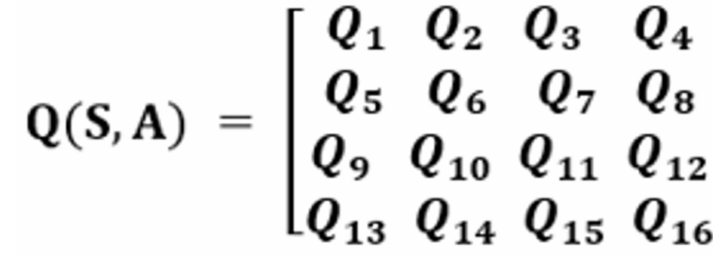
Figure 2. Q Learning Matrix.